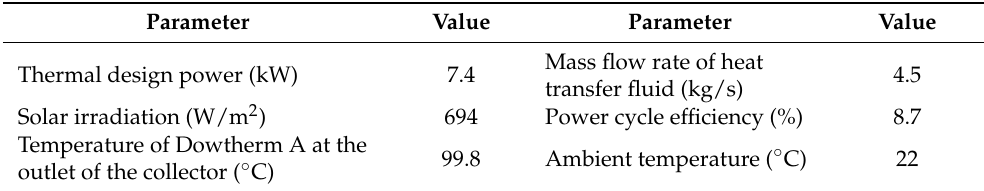
Table 8. Parameters to generate 7.4 kW.